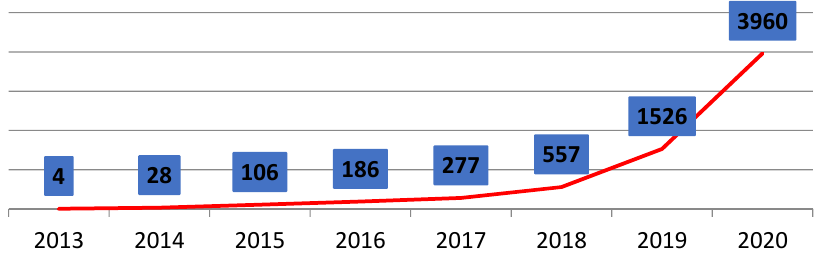
Figure 1. Photovoltaic power plant capacity in Poland in 2013–2020 (data in MW). Source: own elaboration based on Energy Market Agency data [18].